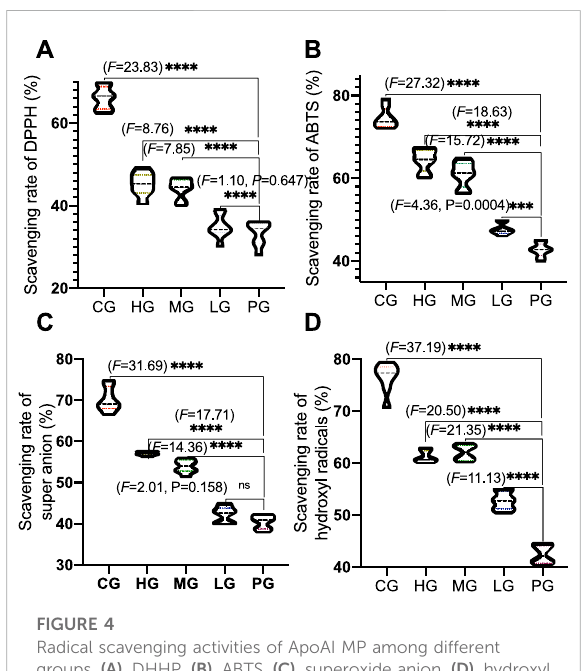
FIGURE 3 The effects of ApoAI MP on circulating lipid pro fi le. (A) , TC. (B) , LDL-c. (C) , HDL-c. (D) , TG. n = 8 for in each group